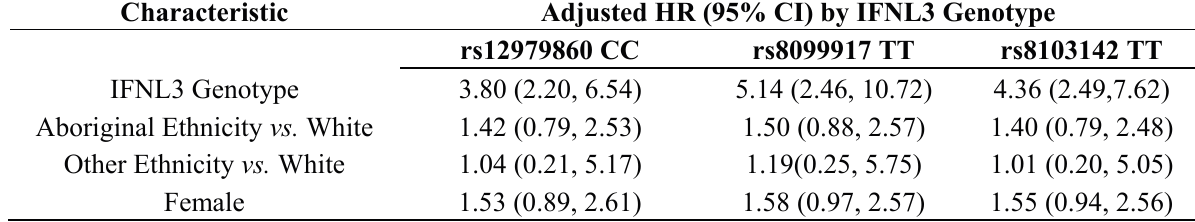
Table 3. Multivariate results of the association of HCV spontaneous clearance with IFNL3